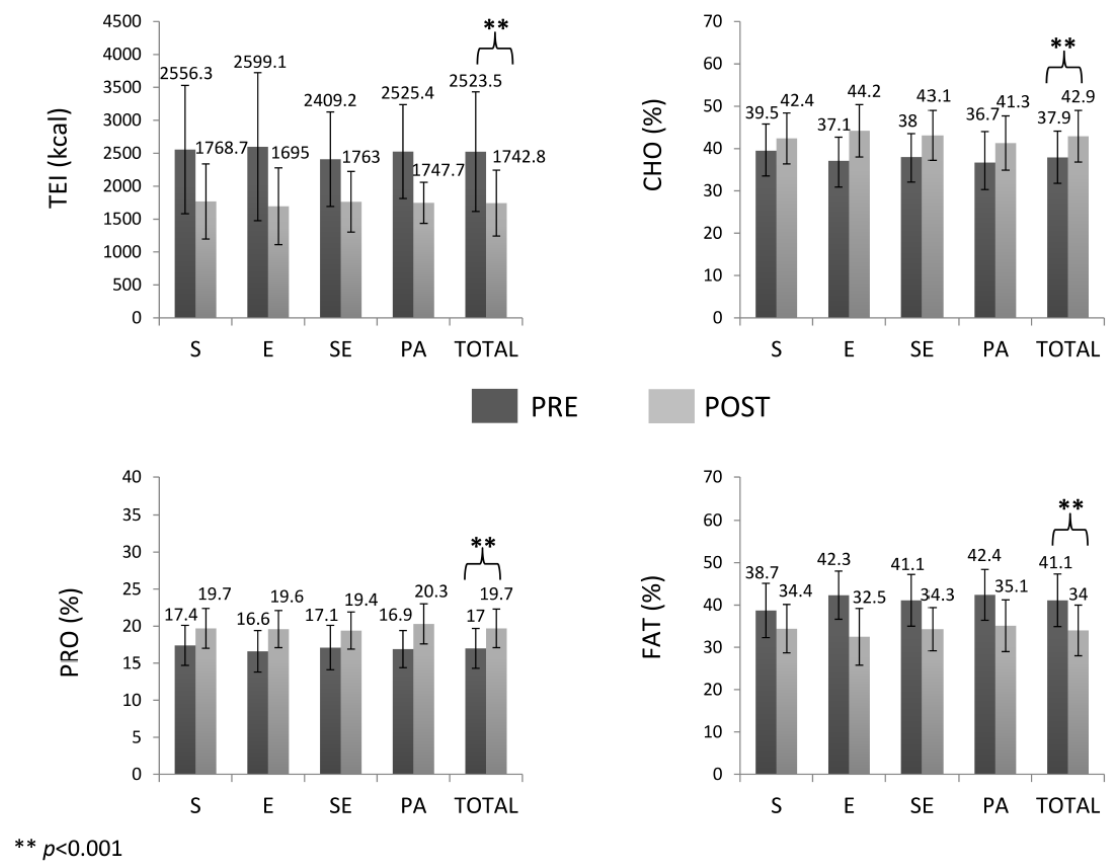
Figure 3. Total energy intake and macronutrient percentages before and after the intervention. TEI: total energy intake; CHO: carbohydrate intake; PRO: protein intake; FAT: fat intake; S: strength training group; E: endurance training group; SE: combined strength plus endurance training group; PA: physical activity recommendations group.